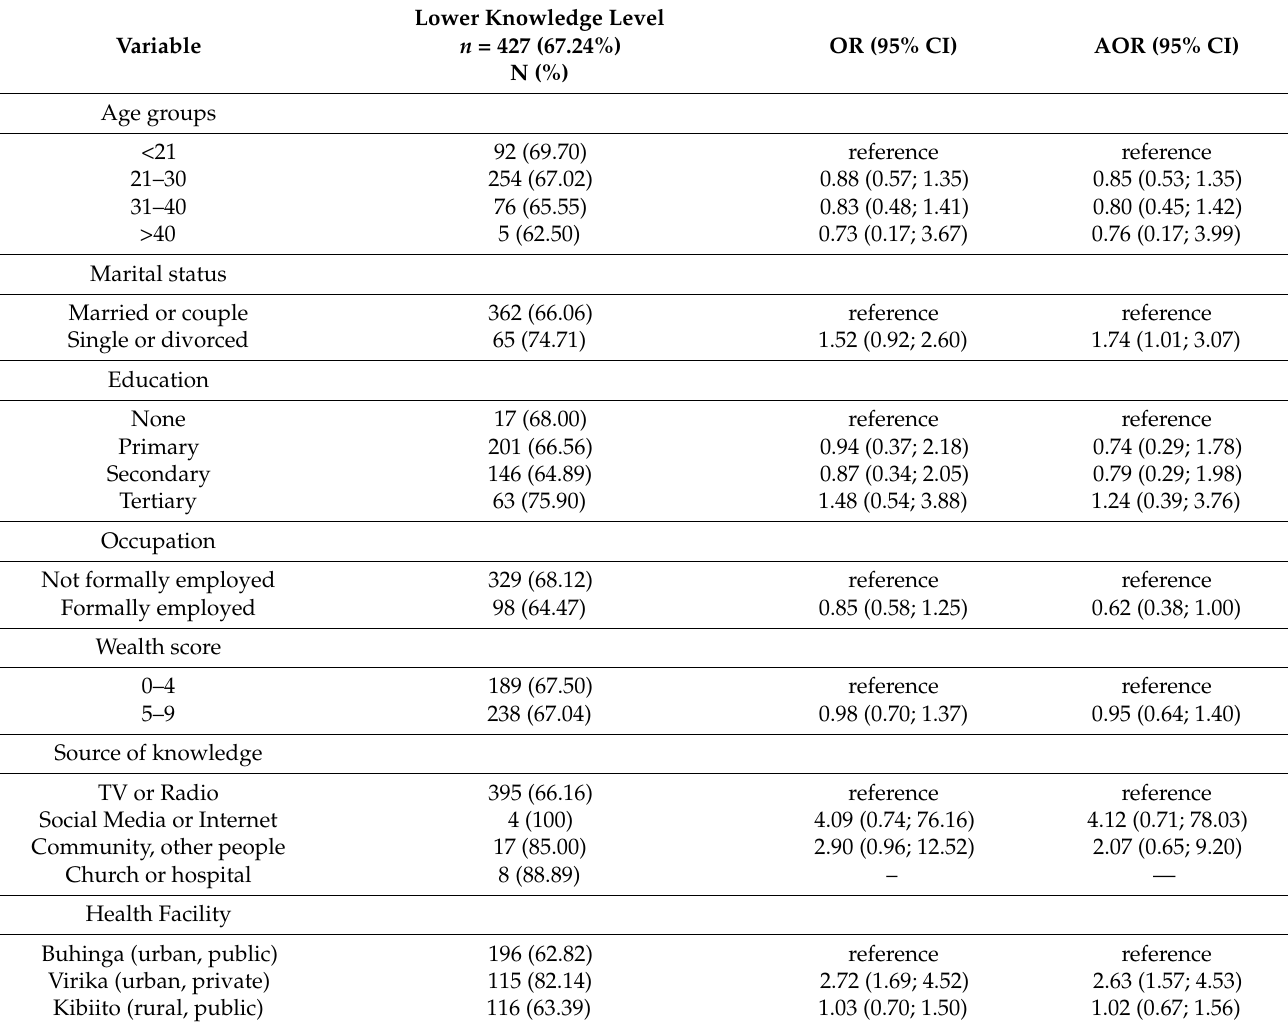
Table 2. Factors associated with lower knowledge level calculated by logistic regression ( n =